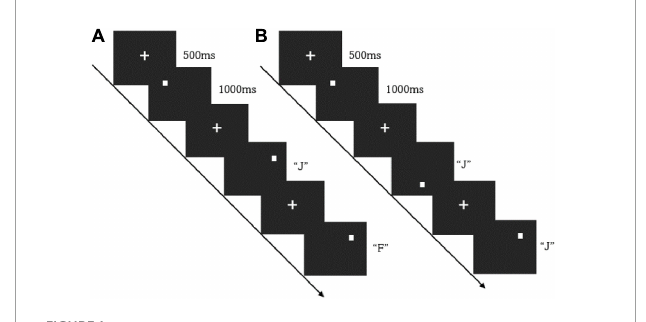
FIGURE1 The flow path of the 1-back (A) and 2-back (B) .